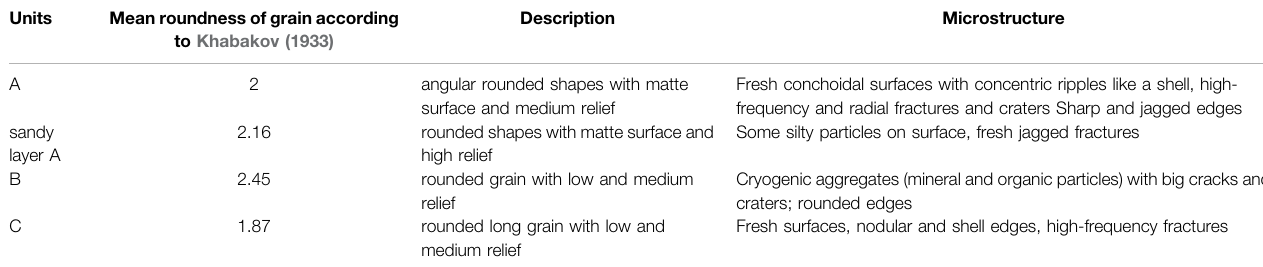
TABLE 3 | Roundness and microstructures of the Duvanny Yar